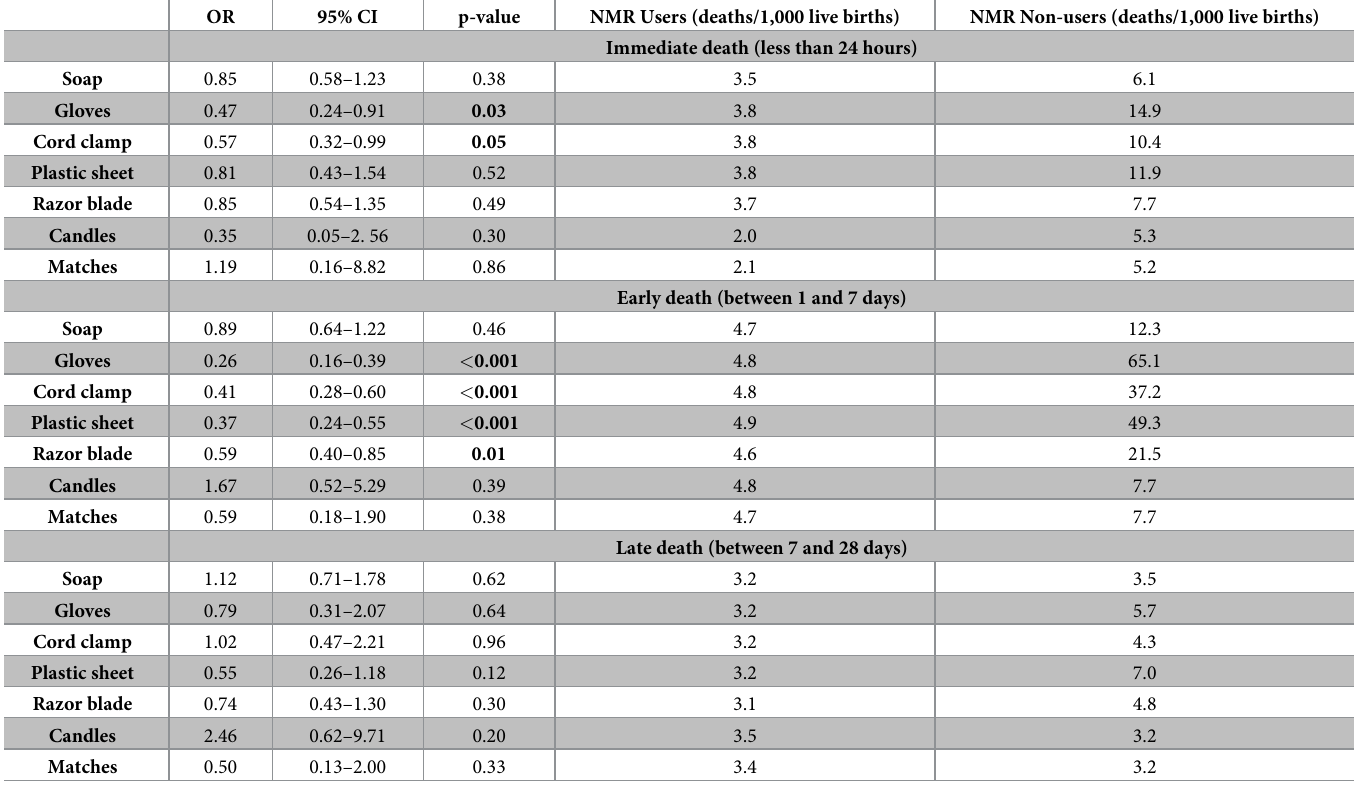
Table 5. Adjusted association between timing of death and the use of clean delivery kit (CDK) components. OR 95%